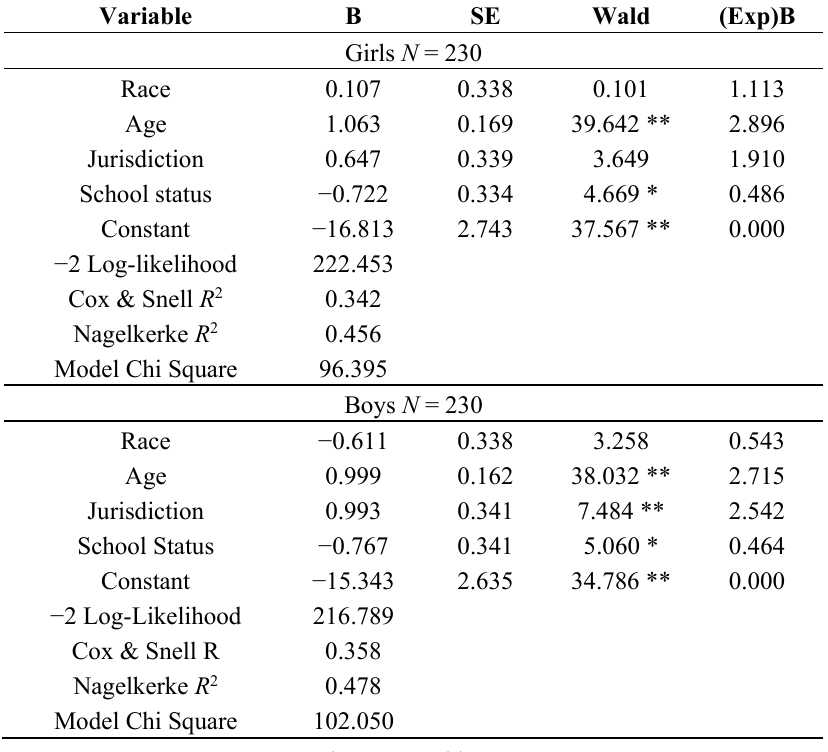
Table 4. Logistic Regression Results of Extra Legal Variables for Girls and